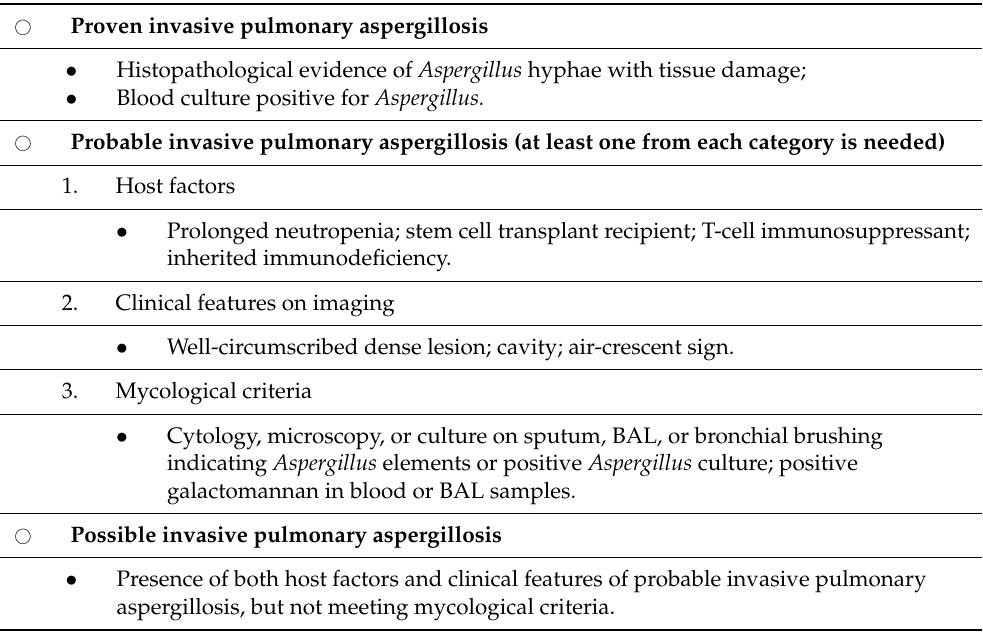
Table 1. European Organization for Research and Treatment of Cancer and the Mycoses Study Group Diagnostic Criteria for